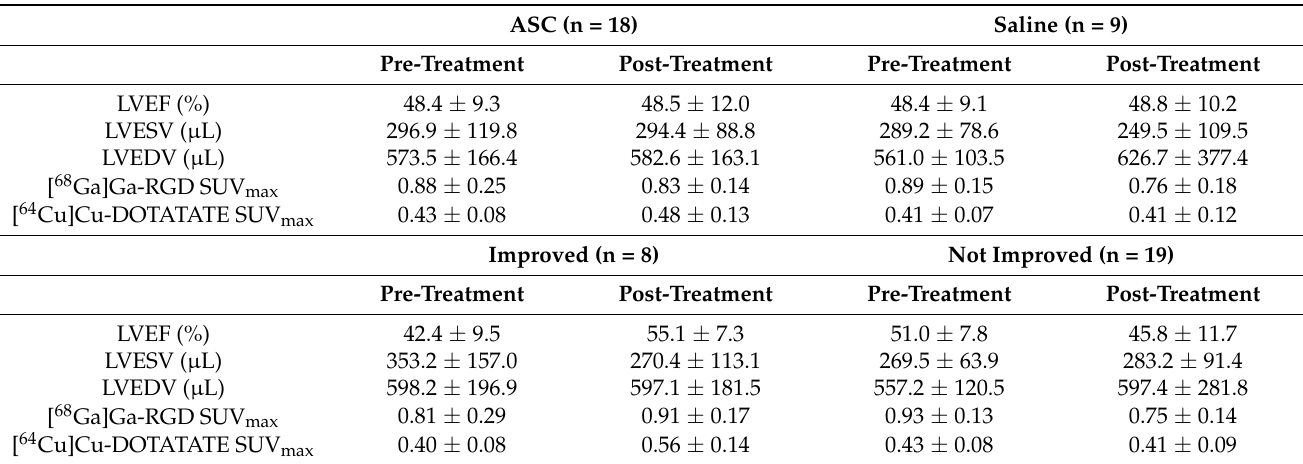
Table 1. Cardiac volumes and tracer uptake across groups. ASC (n =